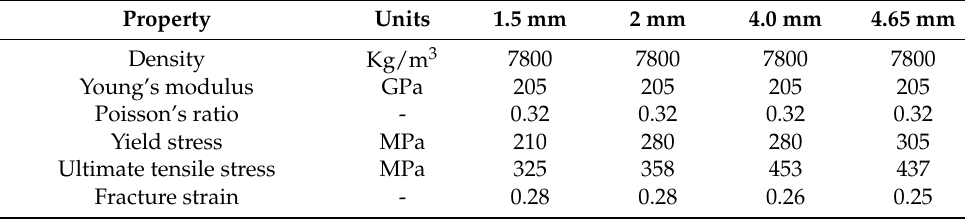
Figure 7. Engineering stress–strain curve of mild steel Q235.